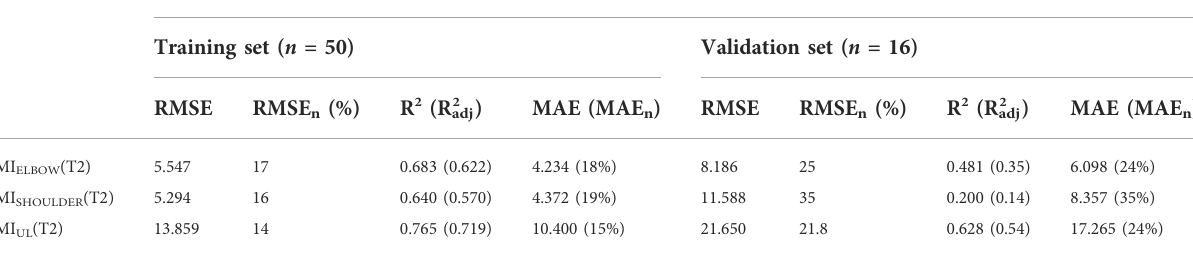
TABLE2SSVpredictivemodelsfortheclinicaloutcomes(MI ELBOW ,MI SHOULDER ,MI UL )attheendofulRT(T2).Resultsofthetrainingandvalidationsets are depicted separately.